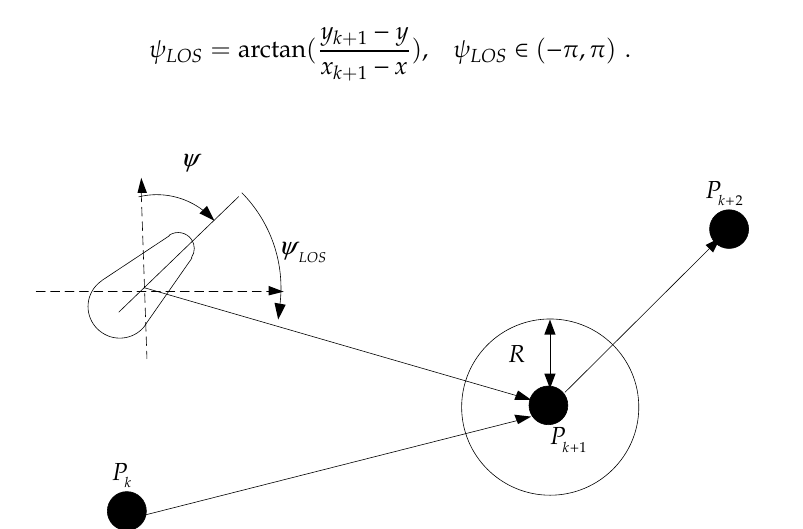
Figure 3. Principle diagram of the line of sight (LOS) navigation algorithm.